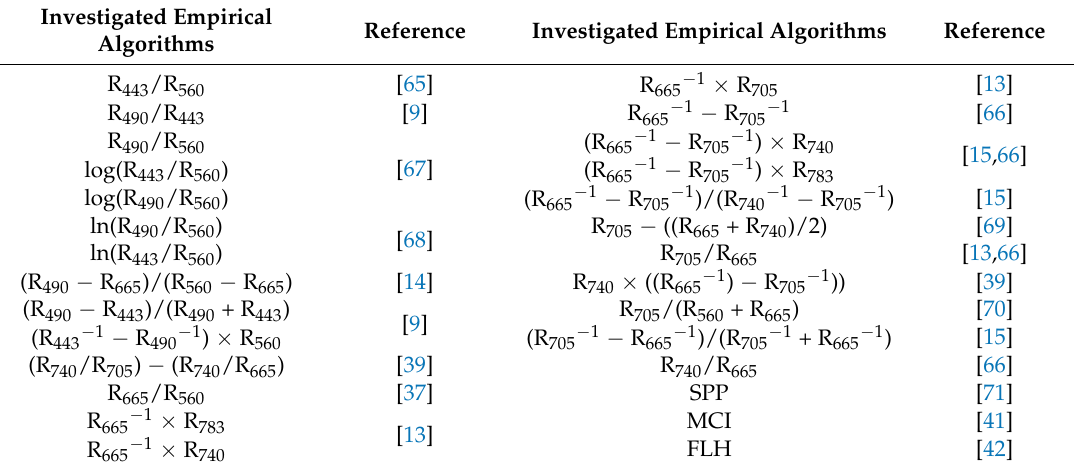
Table 5. The form of the investigated algorithms with references, which were adjusted to S2 MSI wavelengths for this